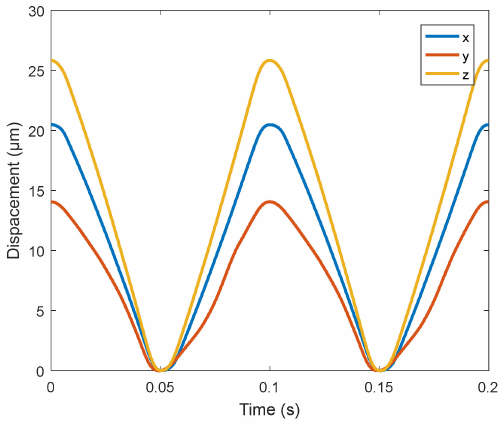
Figure 15. Output trajectory curve at